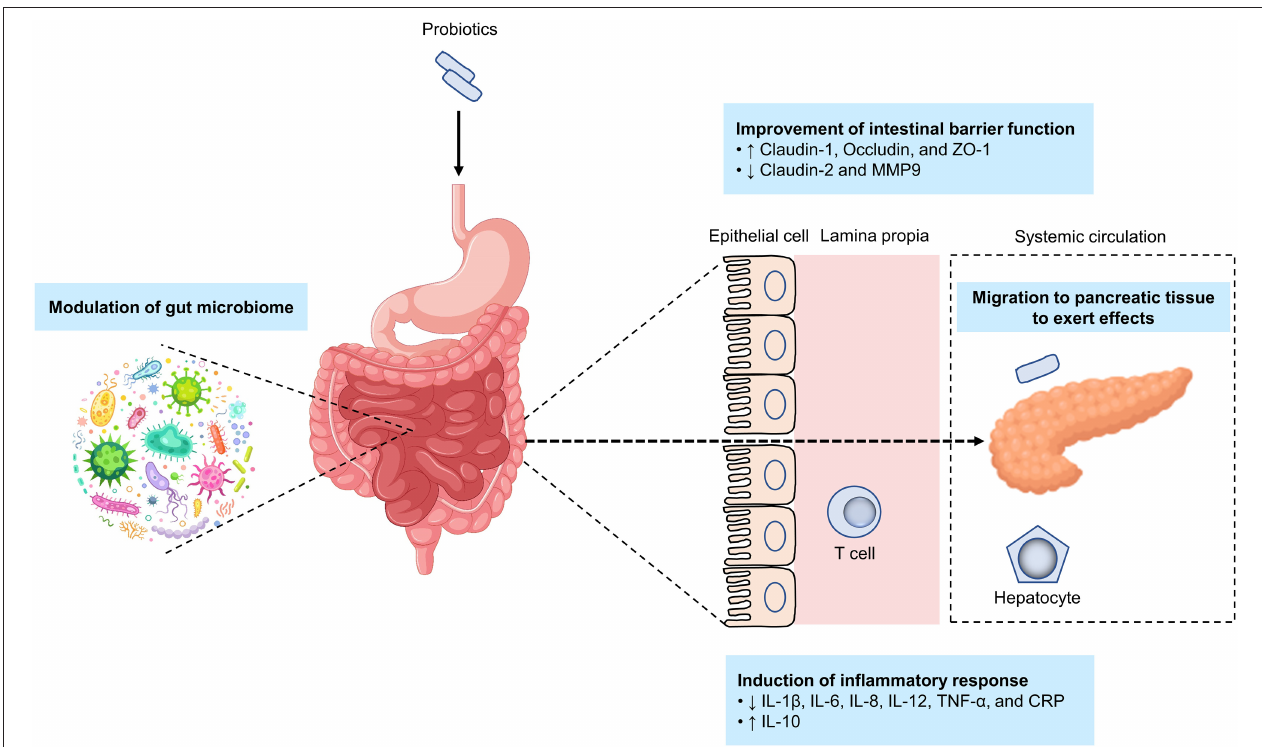
FIGURE 5 | Potential mechanisms by which probiotics alleviate acute pancreatitis. The putative mechanisms by which probiotics alleviate acute pancreatitis include improving the intestinal barrier function, inducting inflammatory responses, modulating the gut microbiome, and targeting pancreatic tissue. ↑ , indicates an increase; ↓ , indicates a